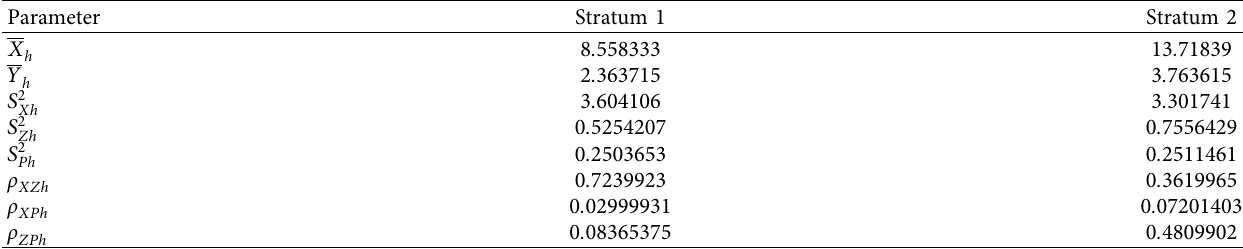
Table 3: Parameters for population II.